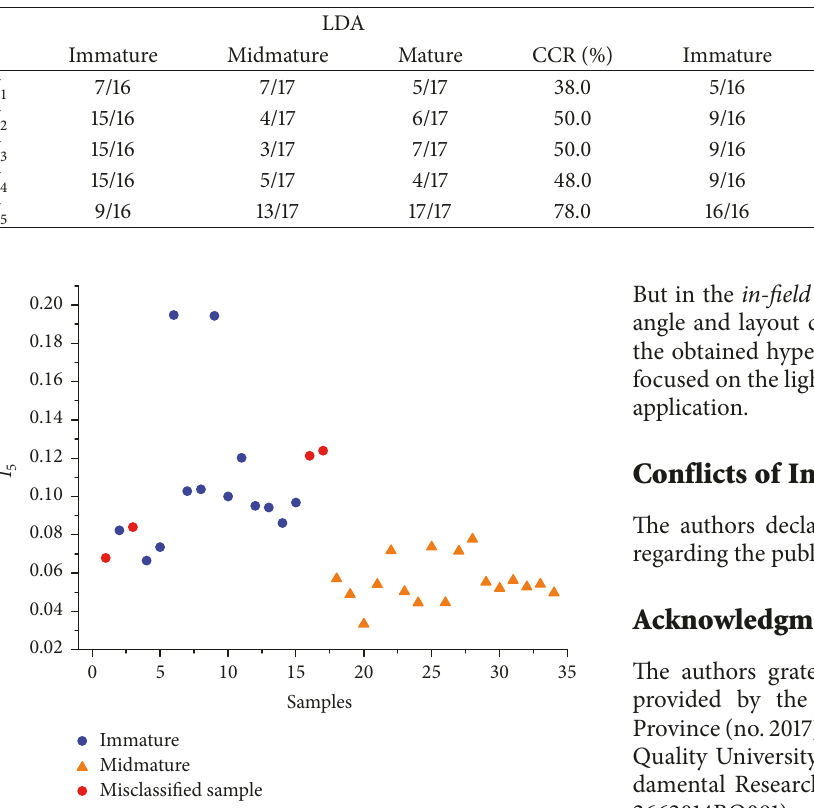
Table 3: The classification results of the different models for the prediction set.